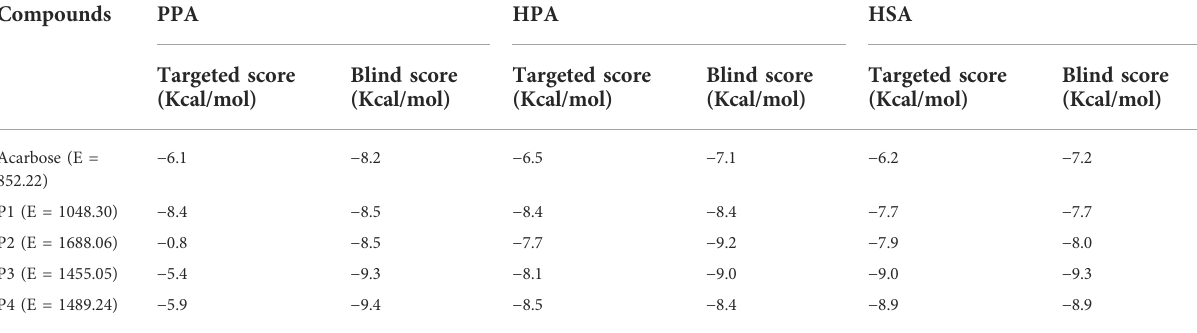
( − 8.4 Kcal/mol) as compared to the pregnane glycosides (P2 – P4) and the reference acarbose ( − 6.1 Kcal/mol). The blind docking revealed comparable binding energy of the pregnanes to PPA. All the SPPs had lower docking scores than the reference acarbose with respect to both targeted docking and blind docking to HPA. Similar results were obtained in the case of HSA.